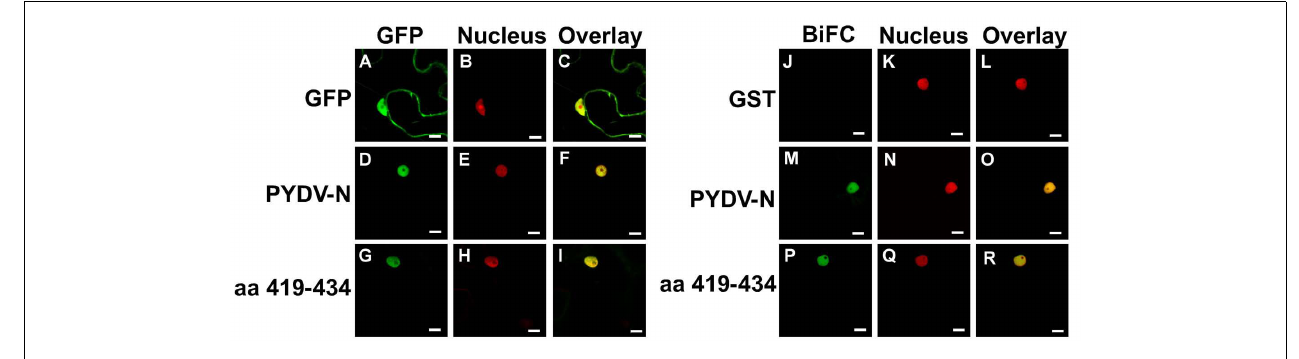
of GFP. (D–F) Localization of full-length PYDV-N fused to GFP. (G–I) Localization of the karyophilic domain of PYDV-N (aa 419–434) fused to GFP. (J–L) BiFC interaction of GST and importin- α . (M–O) BiFC interaction of PYDV-N and importin- α . (P–R) BiFC interaction of aa 419–434 PYDV-N and importin- α . Scale bar = 10 μ m.